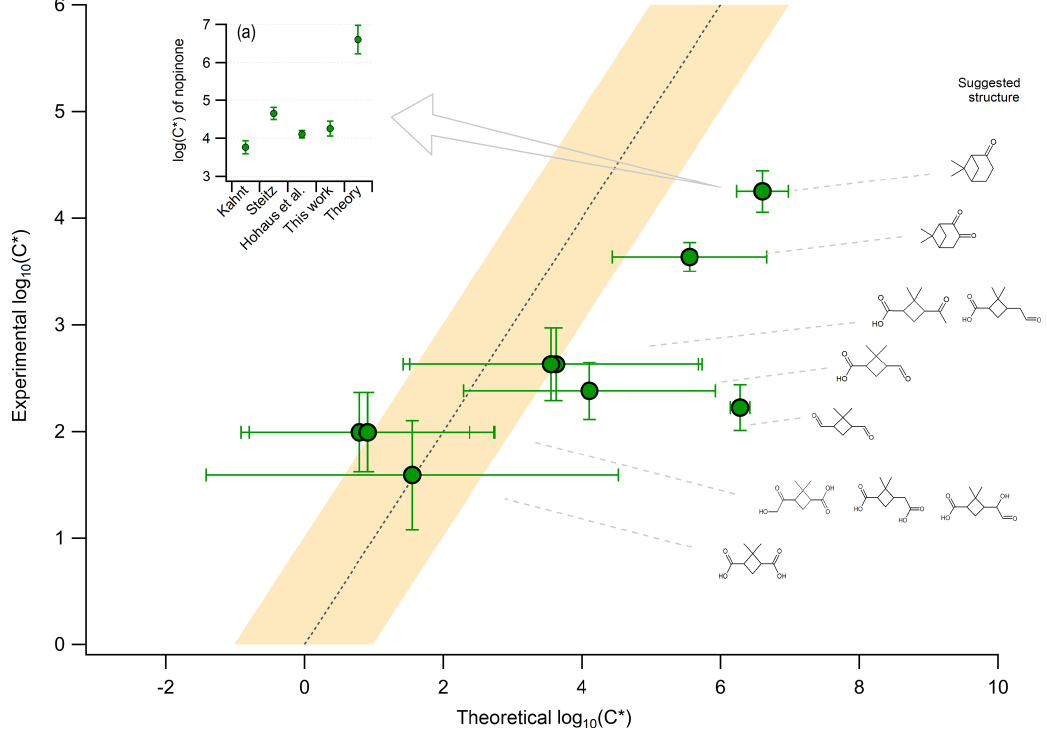
Figure 4. The experimental average saturation concentration obtained from all PTR-based techniques ( y axis) compared to the theoretical calculation of the saturation concentration ( x axis). Theoretical calculations were performed by assuming a chemical structure for the experi- mentally observed ions. The chemical structure was attributed based on known oxidation products of the β -pinene ozonolysis experiment and is shown on the right side of the figure. Error bars on the y axis indicate the ± 1 σ error of the average based on the experimental results from ACM, TD, and CHARON. The error bars for the x axis act as indicators of the minimum and maximum range of nine different theoretical approaches, with the position of the marker indicating the average of these minimum and maximum values. More details on the theoretical calculations are provided in Sect. 2.4. Panel (a) provides experimentally determined values of the saturation concentration for nopinone based on Hohaus et al. (2015) and Kahnt (2012), together with the results of the experimental and theoretical approaches from this